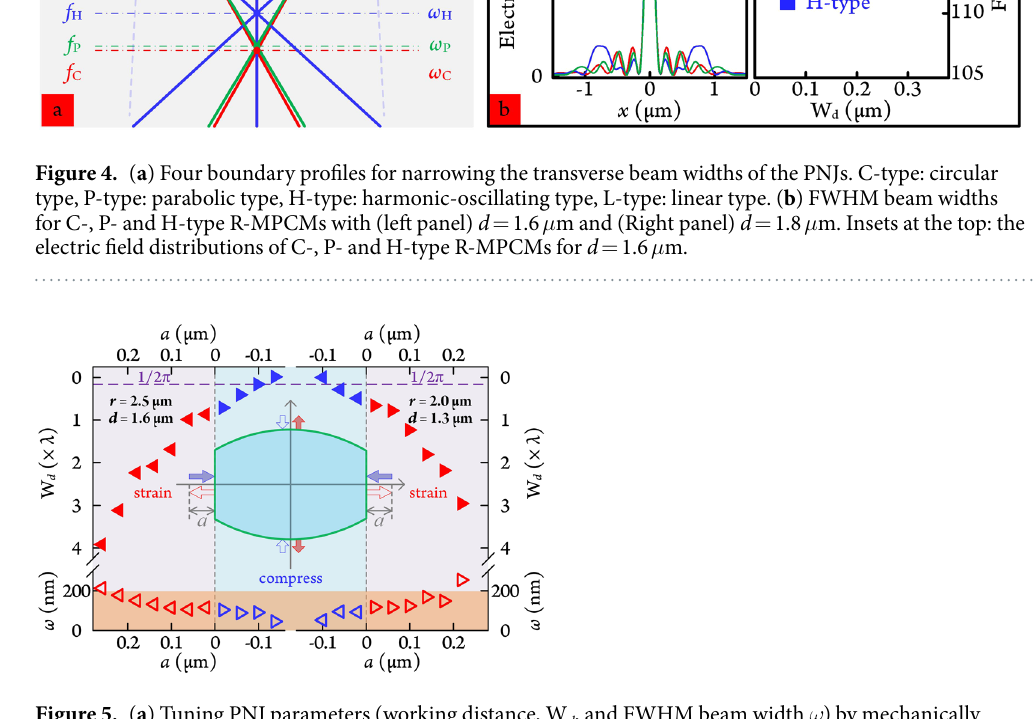
Figure 5. ( a ) Tuning PNJ parameters (working distance, W d , and FWHM beam width ω ) by mechanically straining or compressing the P-type R-MPCMs for r = 2.5 μ m, d = 1.6 μ m; and r = 2.0 μ m, d = 1.3 μ m. Violet dashed line indicates the decay length of evanescent wave ( λ /2 π ). Inset: schematic illustrating strain and compression